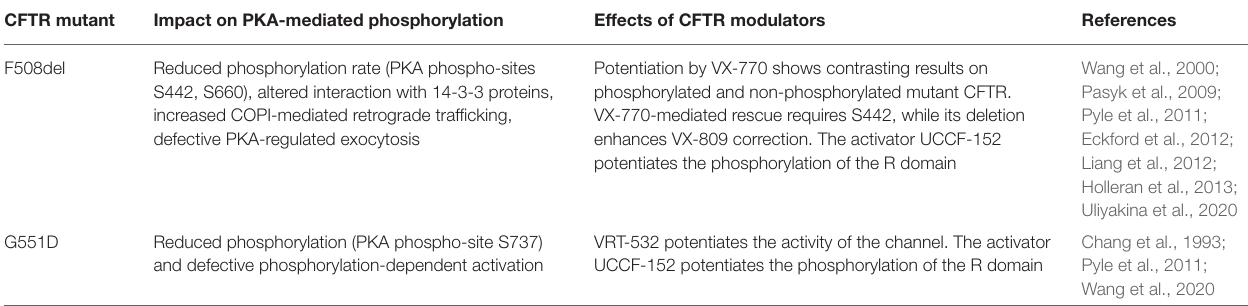
TABLE 2 | Effects of CFTR modulators on PKA-dependent regulation of CFTR mutants. CFTR